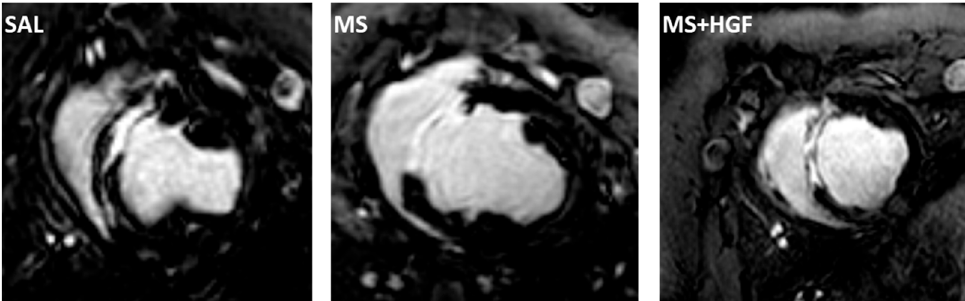
Figure 3. Cardiac Magnetic Resonance. Representative late enhancement images obtained on the short axis view from animals belonging to the three study groups two days after AMI model induction (SAL, MS and MS+HGF).